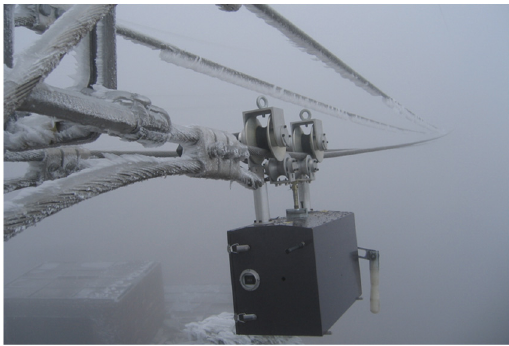
Figure 3. De-icing robot. Figure 3. De-icing